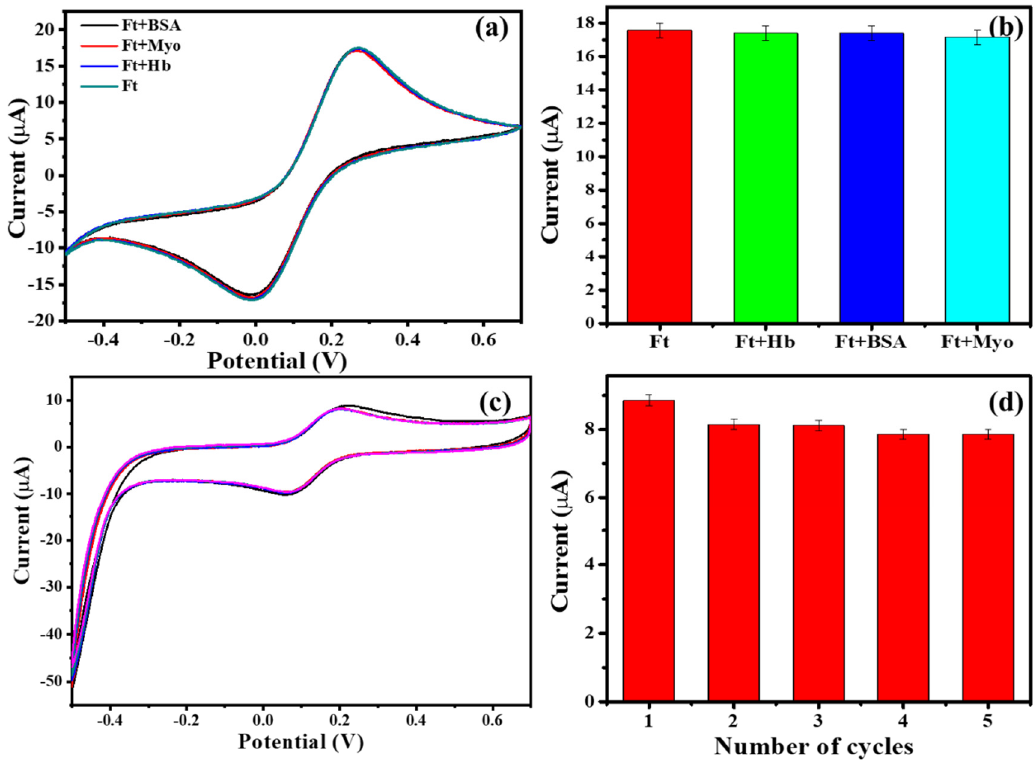
Figure 5. ( a ) Cyclic voltammograms and ( b ) bar chart of currents of obtained from ferritin in the absence and presence of interferents, i.e., hemoglobin (Hb), myoglobin (Myo), and bovine serum albumin (BSA). ( c ) Cyclic voltammograms and ( d ) bar chart of currents of obtained five cycles of ferritin analysis and regeneration.